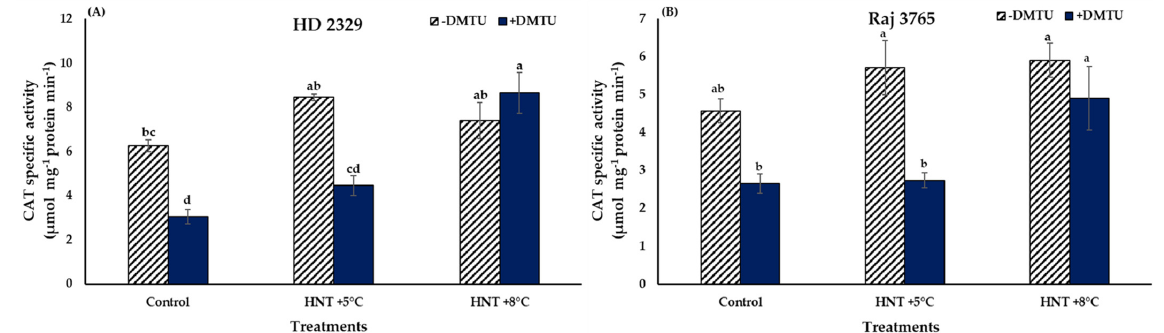
Figure 7. Effect of HNT on catalase specific activity in pistil of wheat genotypes ( A ) HD 2329 (sensitive) and ( B ) Raj 3765 (tolerant) under control, HNT (+5 °C) and HNT (+8 °C) conditions in absence and presence of ROS scavenger (DMTU). Bars represent mean ± SE. Bars with common letter are not significantly different between temperature treatments in a genotype at p < 0.05.